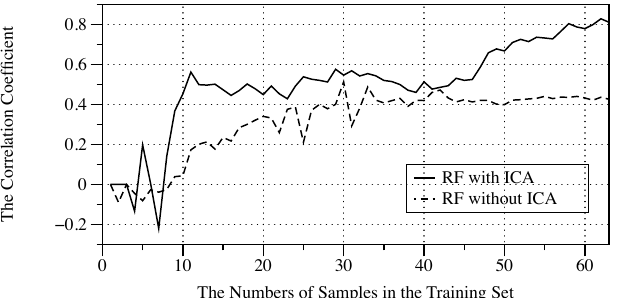
Figure 6. Convergence Experiment results, in which the correlation coefficient varies by the number of samples in the training